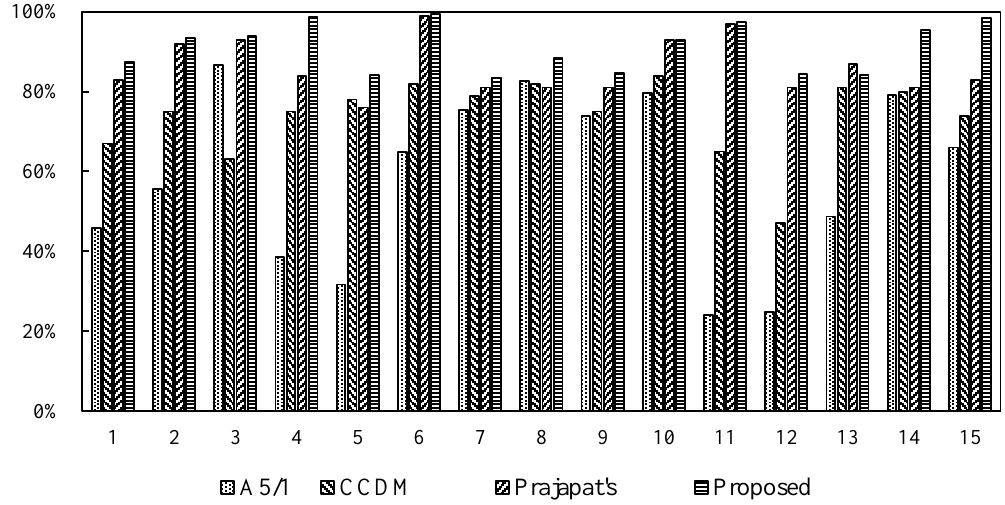
Figure 13. Comparison of p- values [14,15].